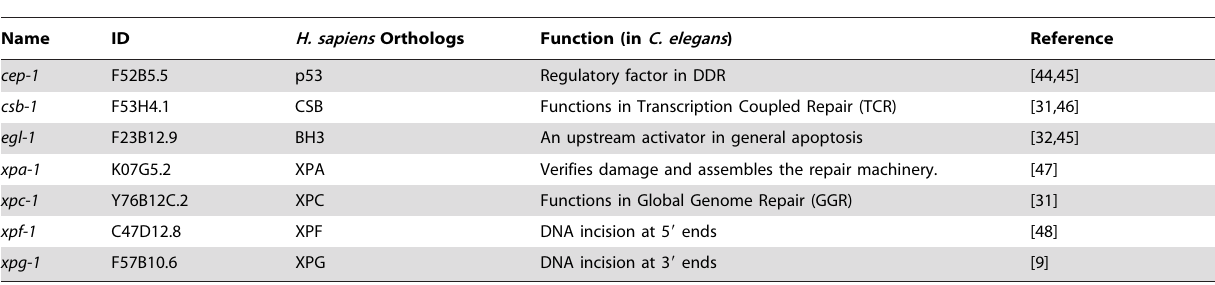
Table 2. Summary of mRNA genes analysed by